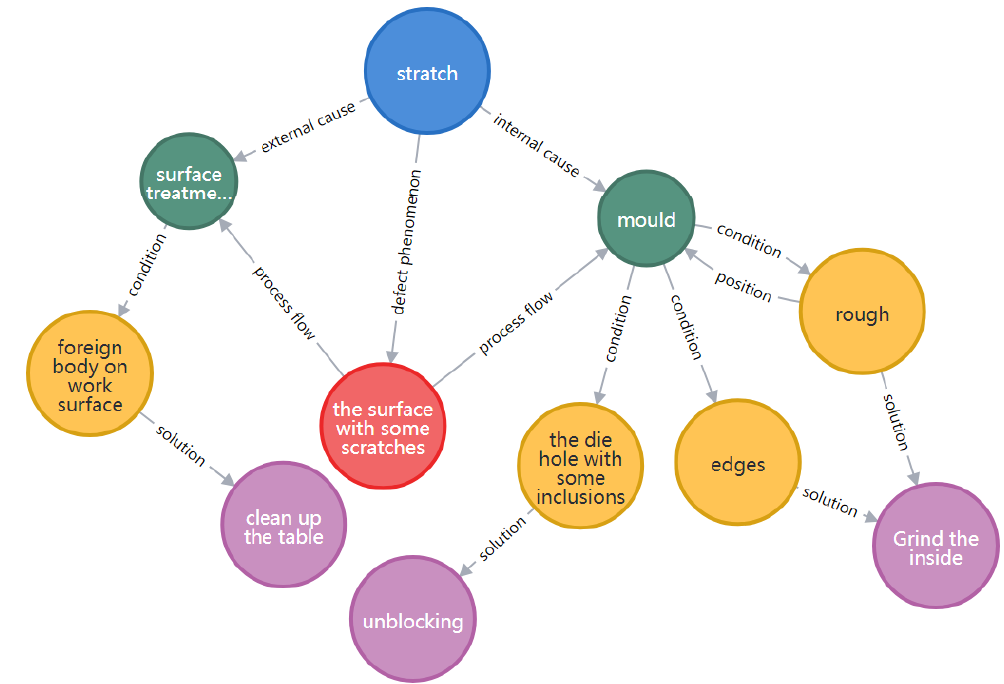
Figure 15. Neo4j visualization of the “ scratch ” defect.